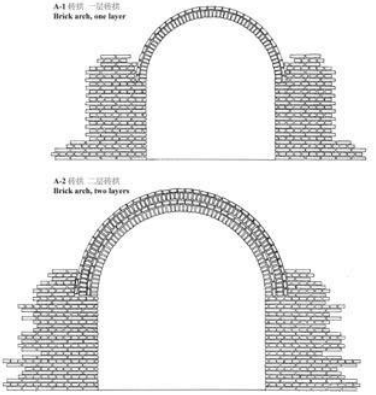
Figure 9. Typological study of the cave arch (brick arches) There are several patterns of bricklaying used in embellishing the cave face.